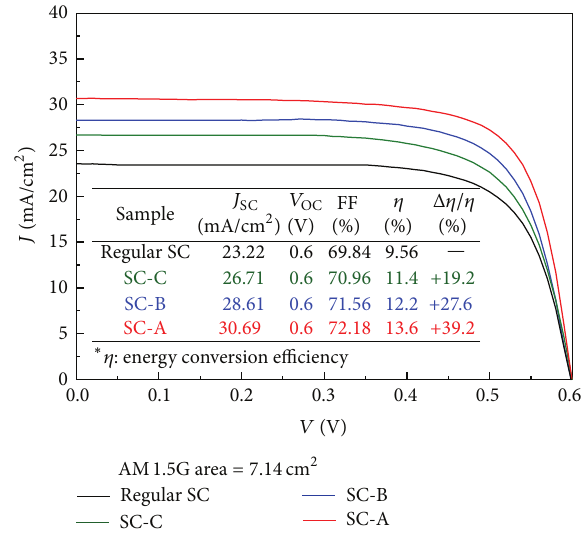
Figure 6: Measured J-V characteristics of regular SC, SC-C, SC-B, and SC-A. Inset shows measured cell